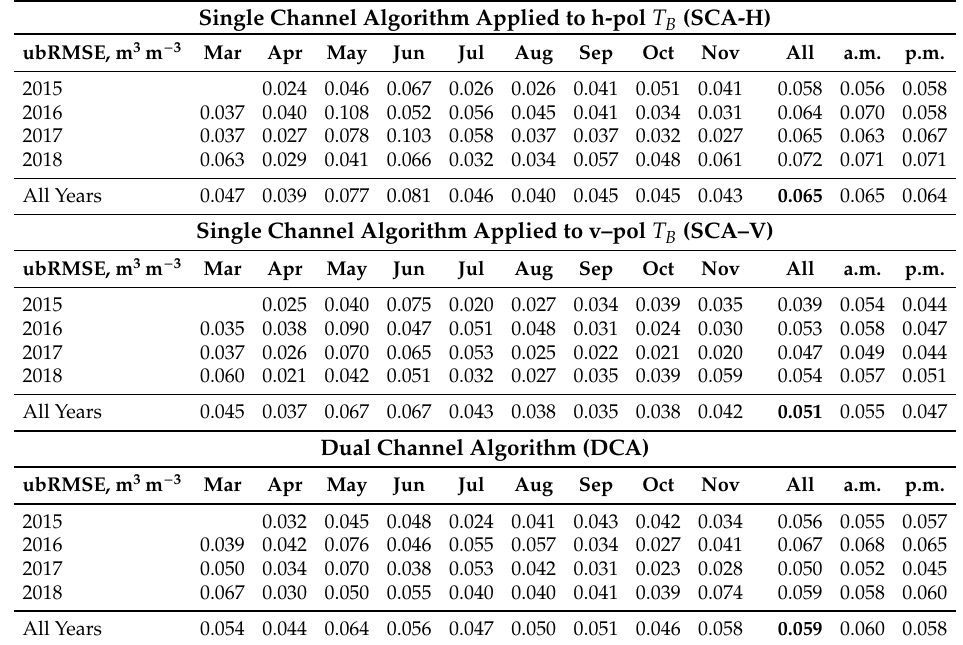
Table 2. Unbiased root-mean-square error (ubRMSE) between SMAP L2SM and South Fork WASM. Single Channel Algorithm Applied to h-pol T B